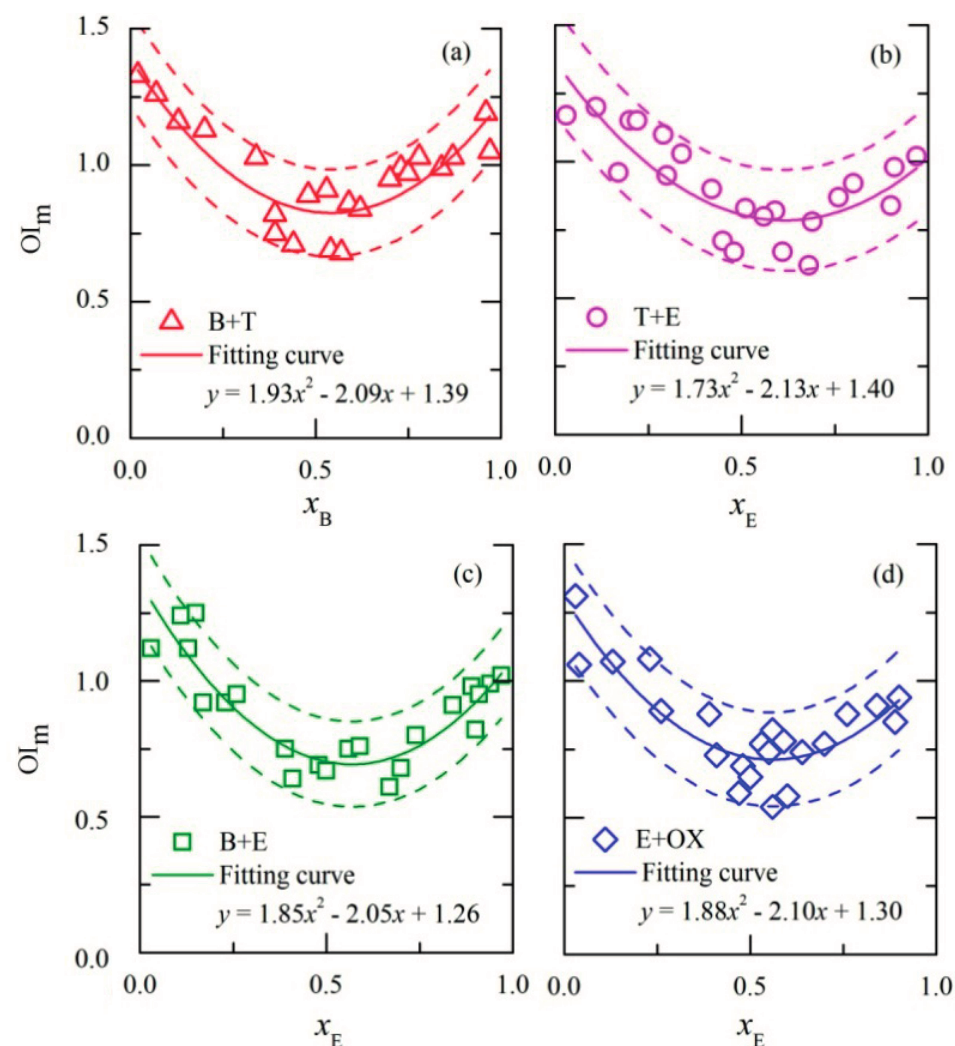
Figure 2. PDE models for mixture of: ( a ) benzene and toluene (B+T); ( b ) toluene and ethyl benzene (T+E); ( c ) benzene and ethyl benzene (B+E); ( d ) ethyl benzene and o -xylene (E+OX). Fitting curve (solid line) of 22 different odor samples and corresponding prediction intervals (dashed line, confidence interval was 0.90) are respectively